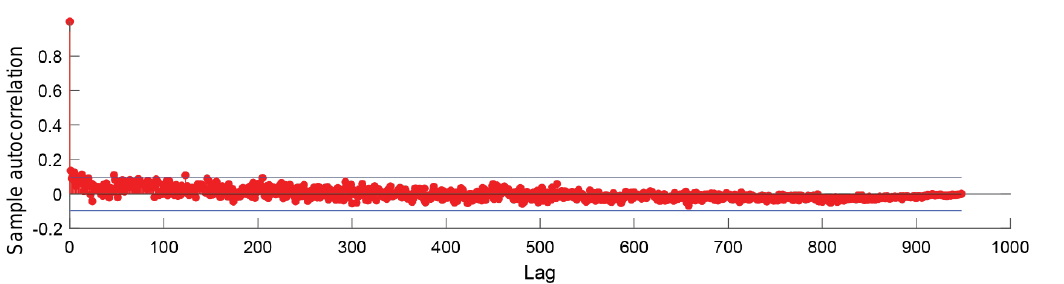
Figure A2. Sample autocorrelation plot for the pentad NSNR landslides. The 99% confidence interval is shown by the blue horizontal lines.